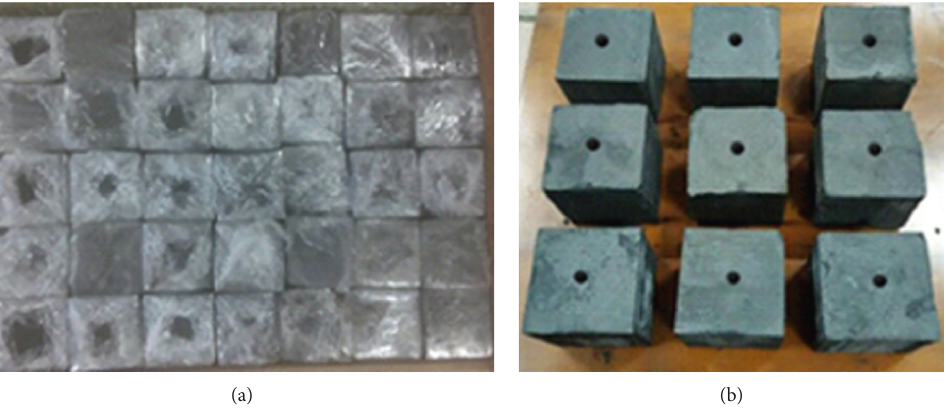
Figure 1: Raw coal samples for experiment.